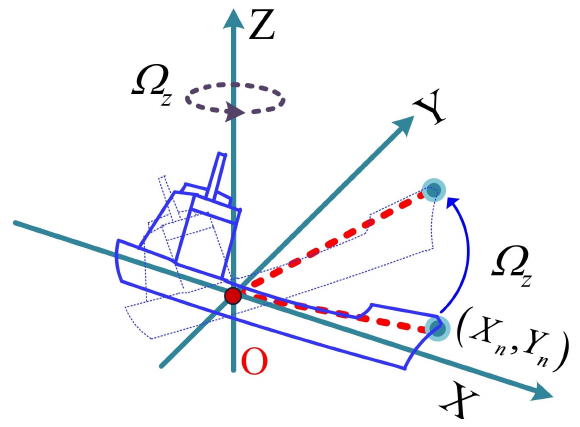
Figure 8. ISAR turntable model of ship